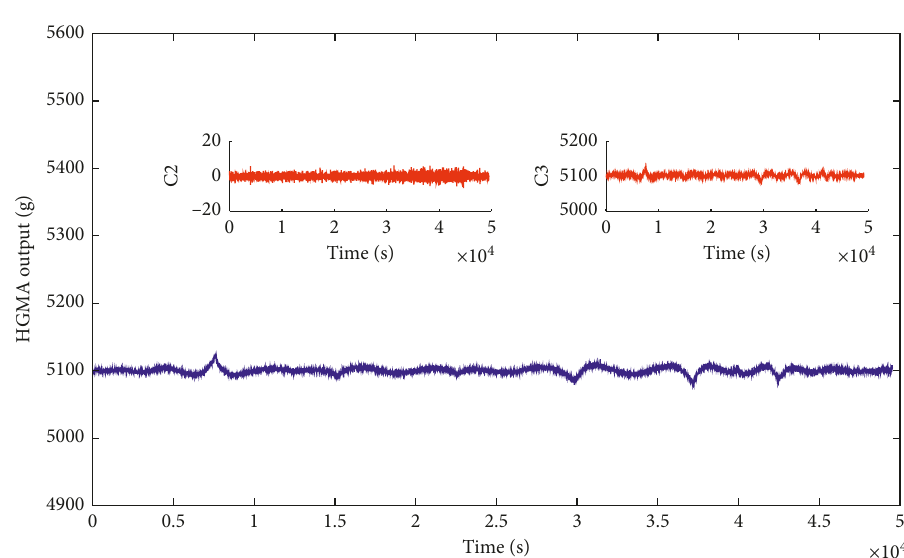
Figure 13: The result of the fusion